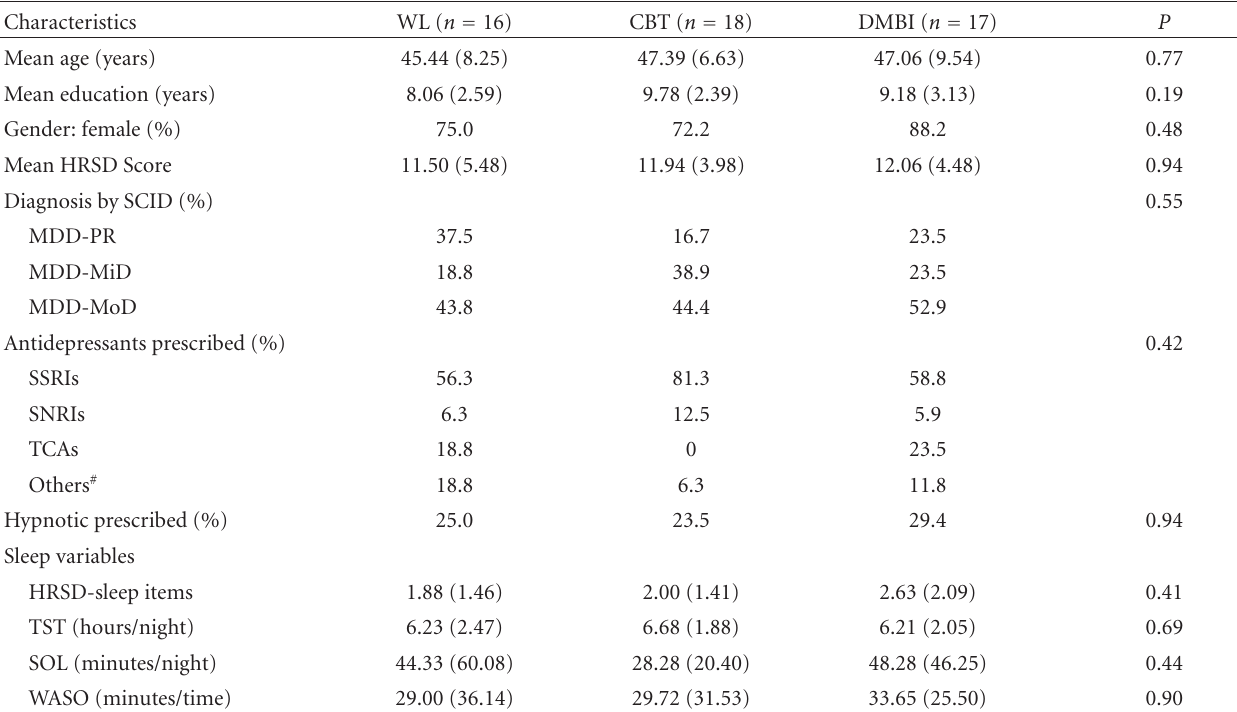
Table 1: Demographic and clinical characteristics at